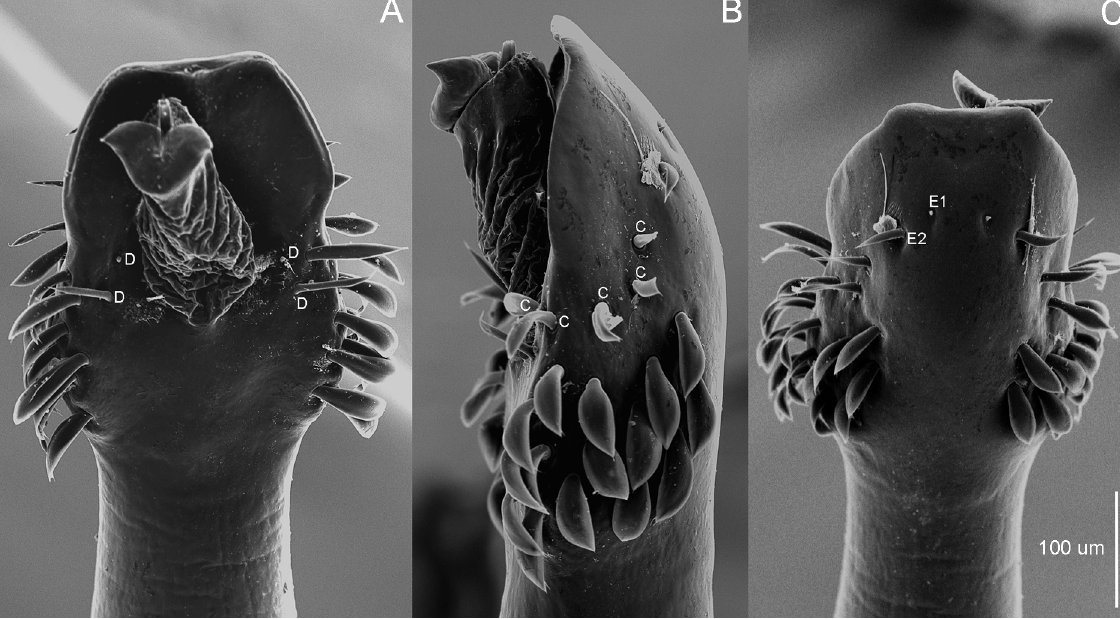
Fig. 7. Troglostygnopsis kalebi sp. nov., ♂, holotype (CNAN-T0850), penis. A . Dorsal view. B . Lateral view. C . Ventral view. Scale bar in C applicable to all